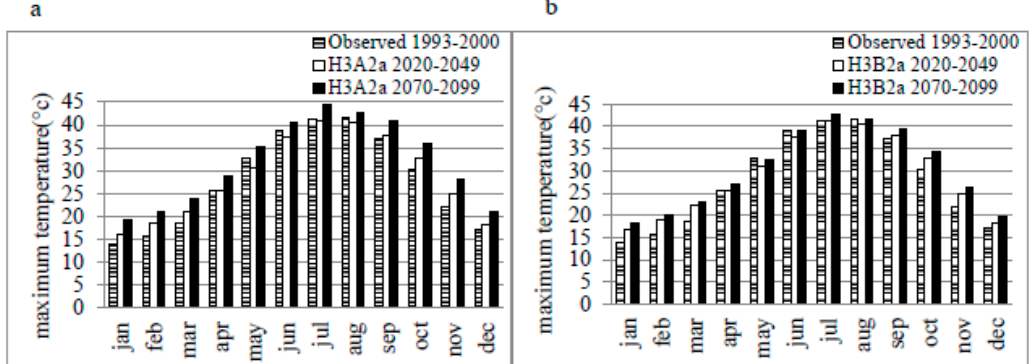
Figure 5. Values of monthly mean observed and predicted maximum temperature under ( a ) A2 and ( b ) B2 scenario in the near and far future.